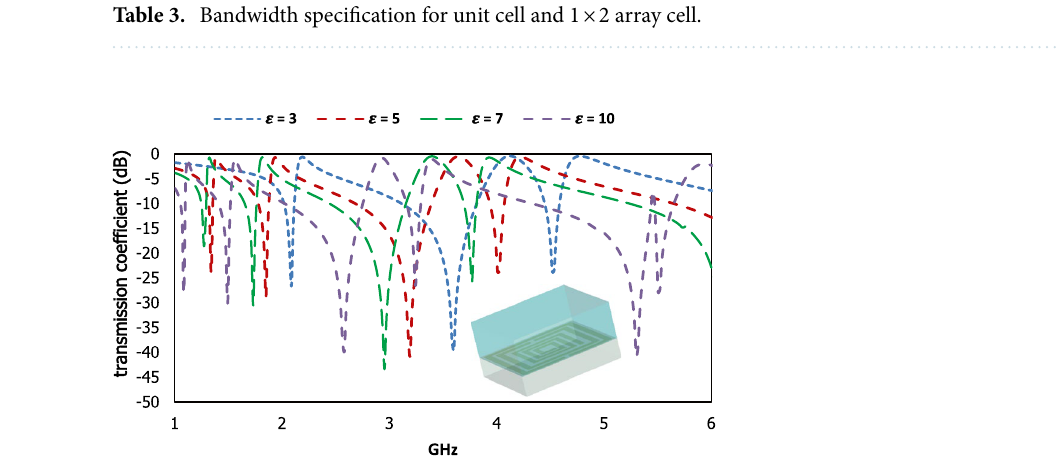
Figure 17. Results of the different dielectric materials as a sample on the proposed